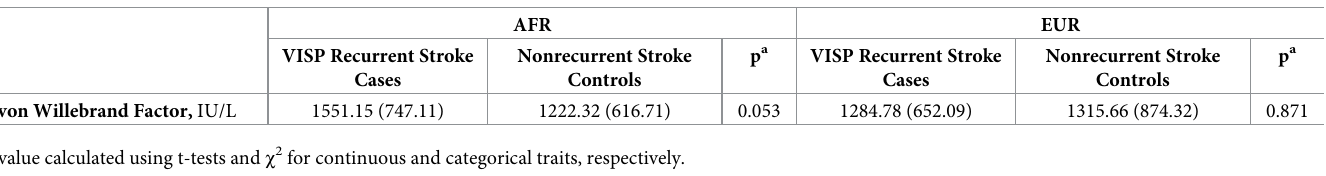
Continuous traits described as mean (SD). Categorical traits described as N (%).